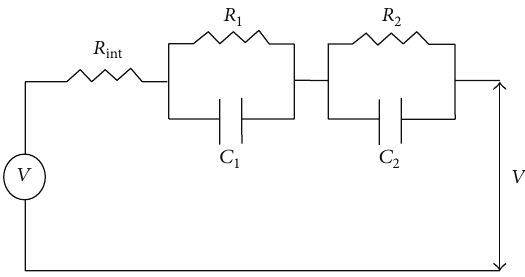
Figure 3: Thermoelectrical